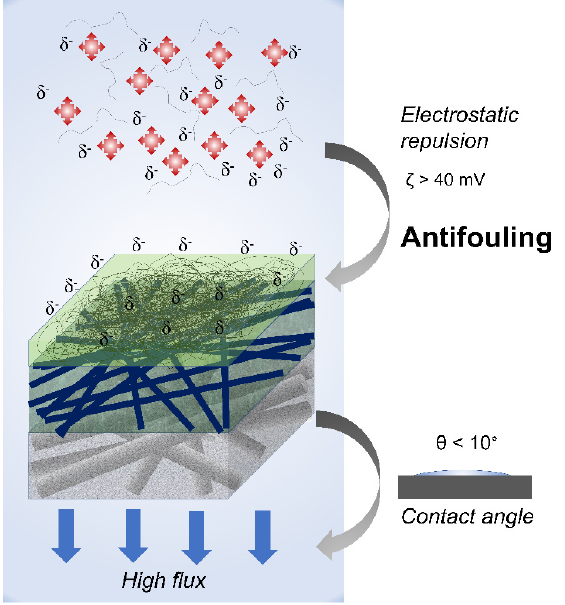
Figure 5. Illustration of antifouling behavior of nanocellulose barrier layer on nanocomposite mem ‐ brane.